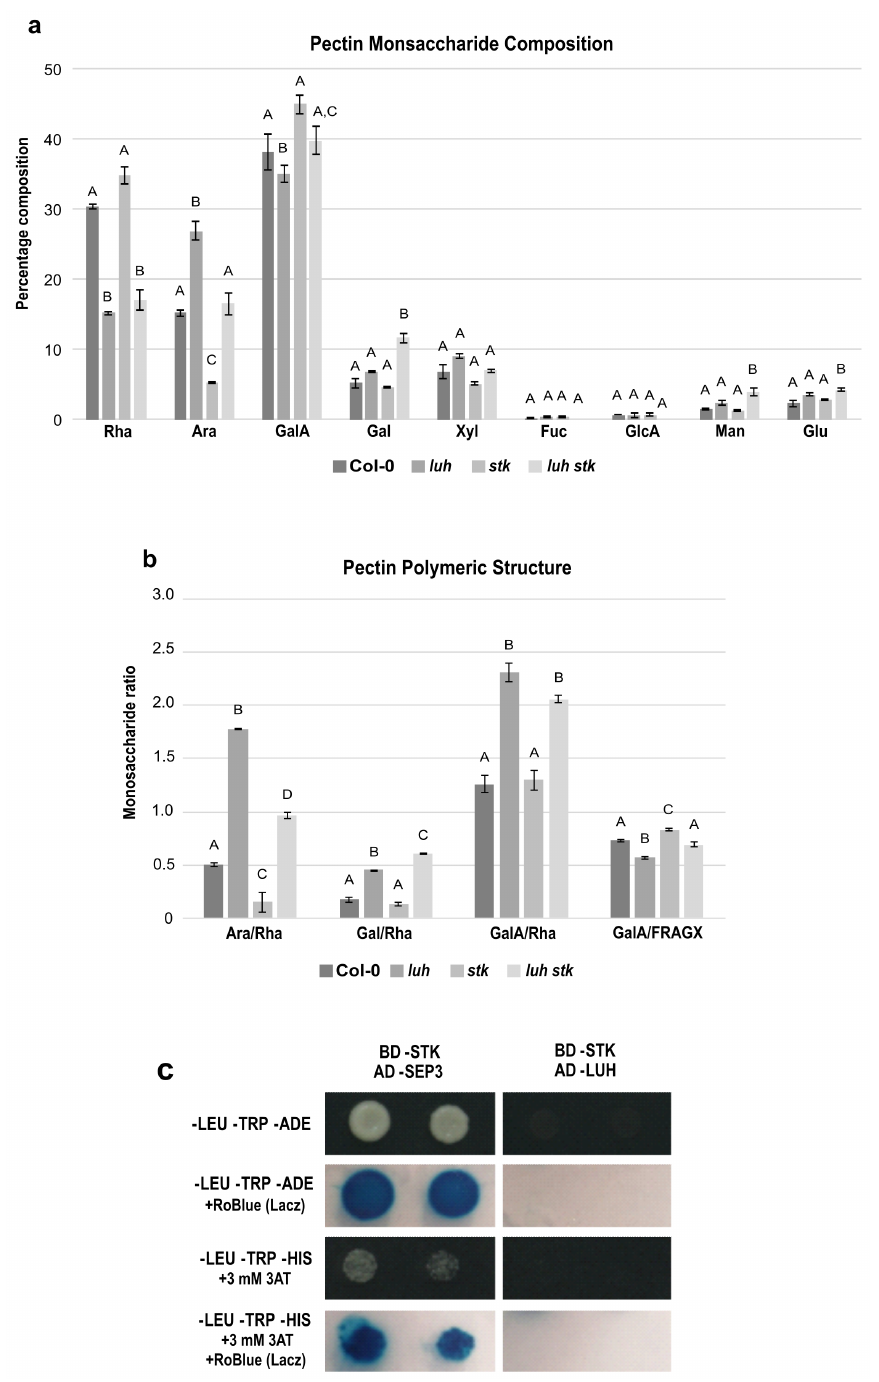
Figure 4. Pectin-enriched monosaccharide composition analysis of seeds from Col-0 (WT), luh and stk single mutants and luh stk double mutant. ( a ) Monosaccharide composition. Rha, rhamnose; Ara, arabinose; GalA, galacturonic acid; Gal, galactose; Xyl, xylose; Fuc, fucose; GlcA, glucuronic acid; Man, mannose; Glc, glucose. Statistical analyses were performed using ANOVA followed by Tukey’s HSD test. Different letters indicate statistically significant differences ( p < 0.01). ( b ) Pectin distribution and ramification. Ara/Rha ratio, Gal/Rha ratio, GalA/Rha ratio, and GalA/FRAGX (fucose, rhamnose, arabinose, galactose, xylose). Statistical analyses were performed using ANOVA followed by Tukey’s HSD test. Error bars represent the SE of 4 biological replicates. Different letters indicate statistically significant differences ( p < 0.01). ( c ) Yeast two-hybrid assay to test the LUH–STK protein interaction.